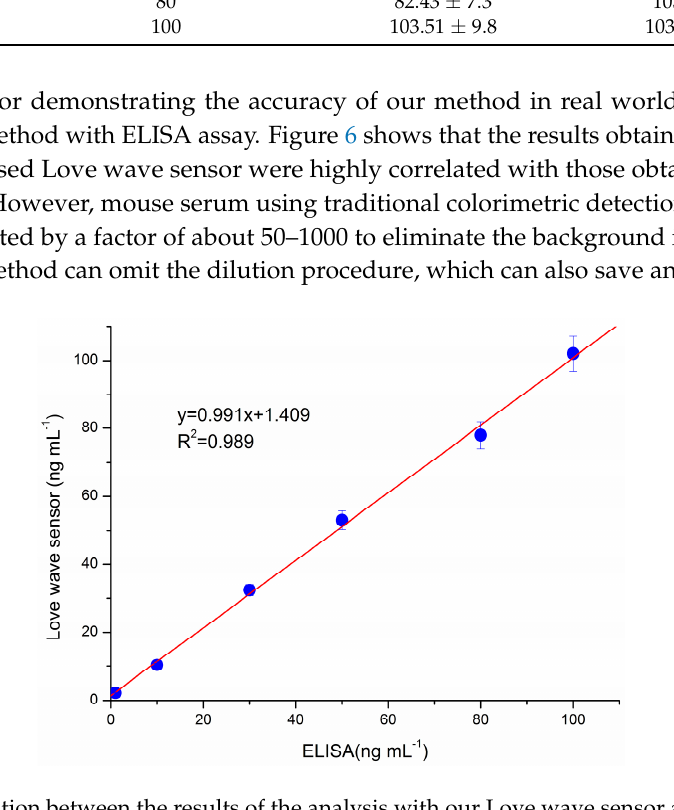
Figure 6. Correlation between the results of the analysis with our Love wave sensor and commercial ELISA assay.